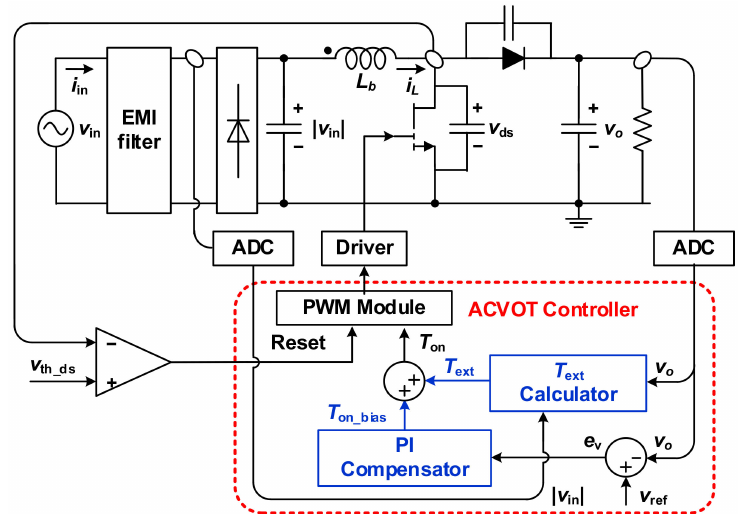
Figure 6. Implementation of the proposed control.